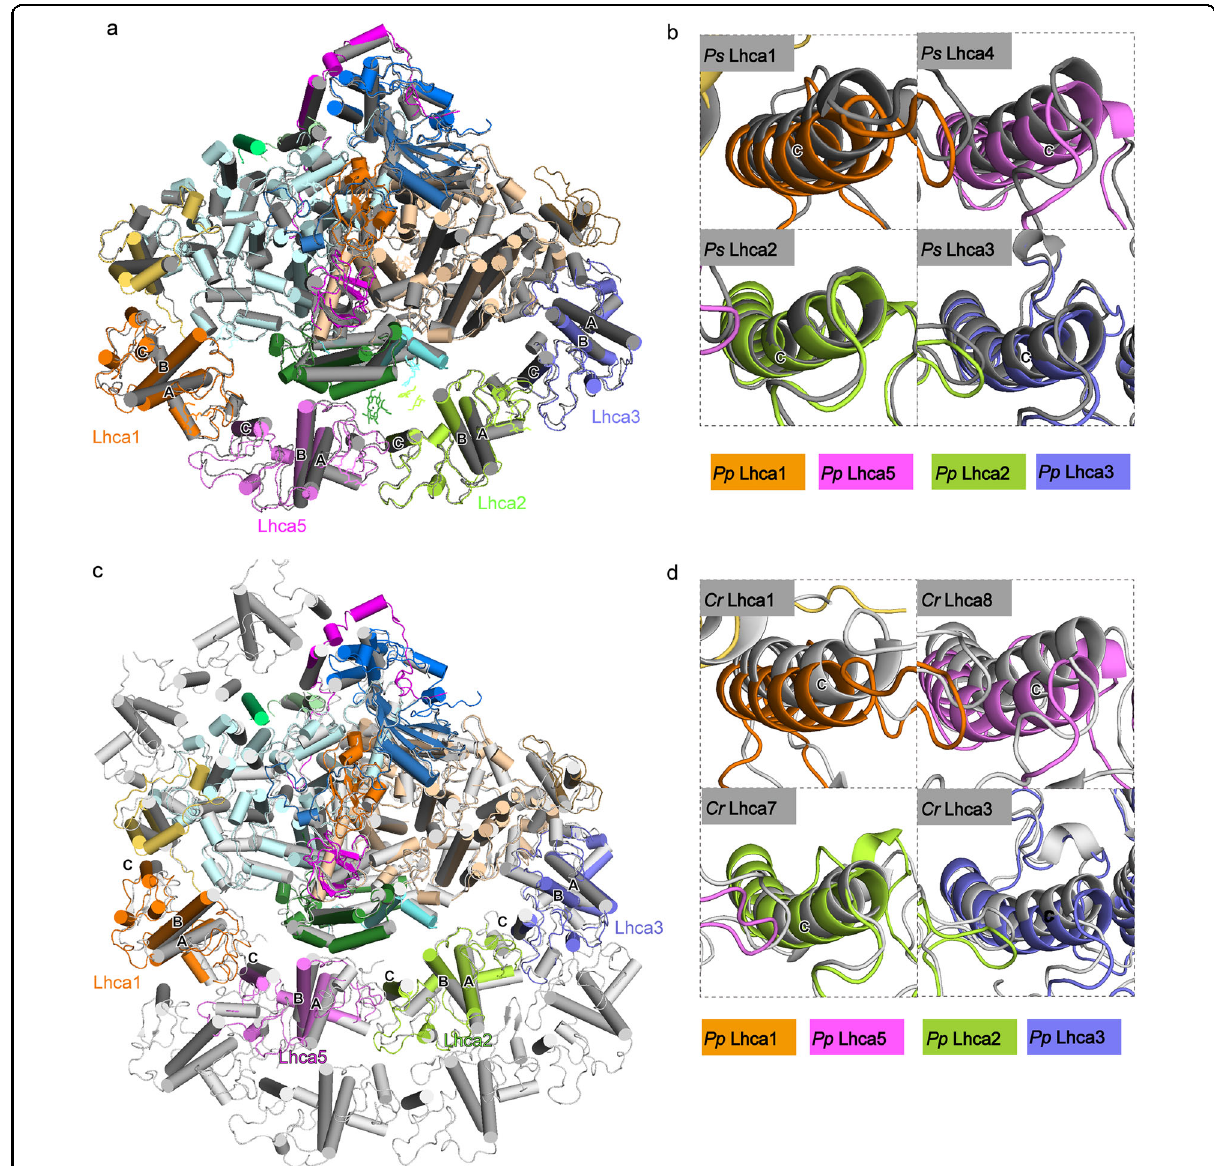
Fig. 6 Comparison of the PSI – LHCI structures. a Superposition of the PSI – LHCI structures of P . patens and P . sativum based on the helices of PsaA/ B. Regions of the helix C of each Lhca subunit in panel a was enlarged and shown in panel b . c Superposition of the PSI – LHCI structures of P . patens and a green algae C . reinhardtii based on the helices of PsaA/B. Regions of the helix C of each Lhca subunit in panel c was enlarged and shown in panel d . Color codes and PDB ID codes: Ps PSI – LHCI, gray, 4XK8; Cr PSI – LHCI, light gray, 6IJO; Pp PSI – LHCI, the same color codes as in Fig. 1,